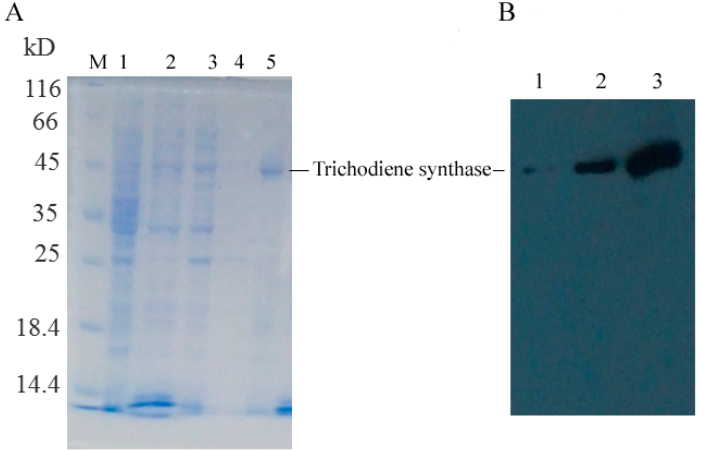
Figure 5. Identification of Tri5 gene: ( A ) expression and purification of trichodiene synthase encoded by Tri5 gene from M. roridum : M. Protein Marker; 1. Un-induced sample; 2. Total proteins of induced samples; 3. Supernatant of induced sample; 4. 55 mM imidazole eluate; and 5. 100 mM imidazole eluate; and ( B ) Western blot analysis of trichodiene synthase encoded by Tri5 gene from M. roridum : 1. Total proteins of un-induced sample; 2. Supernatant of induced sample; and 3. 55 mM imidazole eluate.